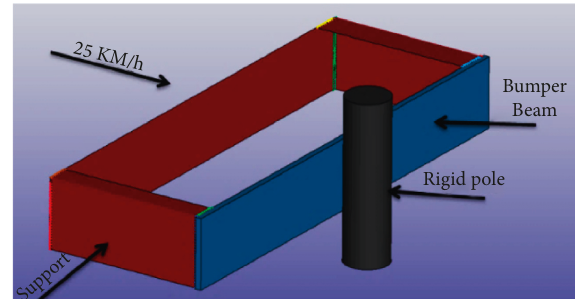
Figure 10: Side beam